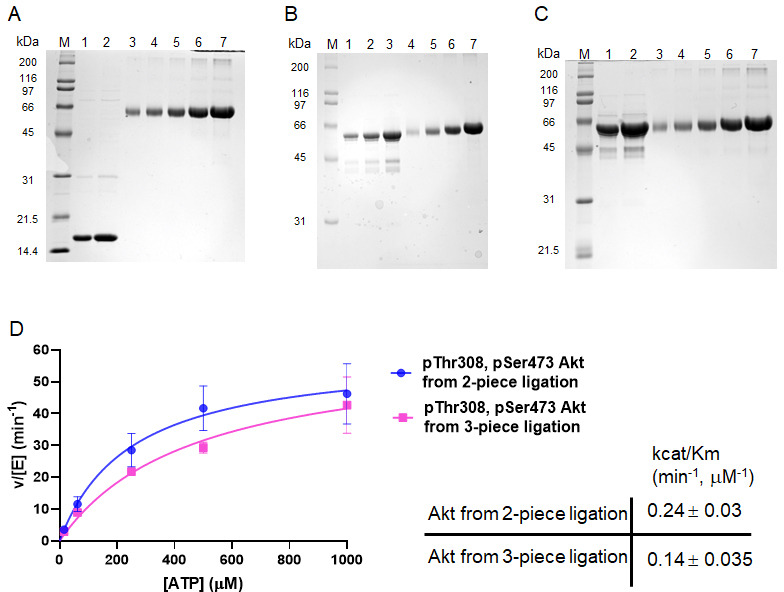
Generation of segmentally 15N, 13C, 2H isotopically labeled Akt proteins.(A) 15N, 13C, 2H isotopically labeled PH domain purified from 1 L of E. coli expression, diluted 20-fold, and loaded 5 and 10 µl (lanes 1–2); lanes: 3–7. (B–C) Pure segmentally isotopically labeled full-length pThr308 Akt proteins with non-p C-tail (B, lanes 1–3: 2.5, 5, 10 µl) and di-pSer477/pThr479 (C, lanes 1–2: 5, 10 µl) diluted 10-fold; lanes 4–7: BSA standards. (D) Steady-state kinetic plots v/[E] versus [ATP] with 20 µM GSK3 peptide for semisynthetic pThr308, pSer473 Akt proteins from two-piece (blue) and three-piece (magenta) expressed protein ligation strategies, n = 2. Note that, Akt protein obtained from three-piece ligation is lacking the N-terminal tags: Flag, HA and 6xHis. The obtained catalytic efficiencies (apparent kcat/Km values) expressed in the table (right) from at least two independent repeats performed for each assay, S.D. shown.